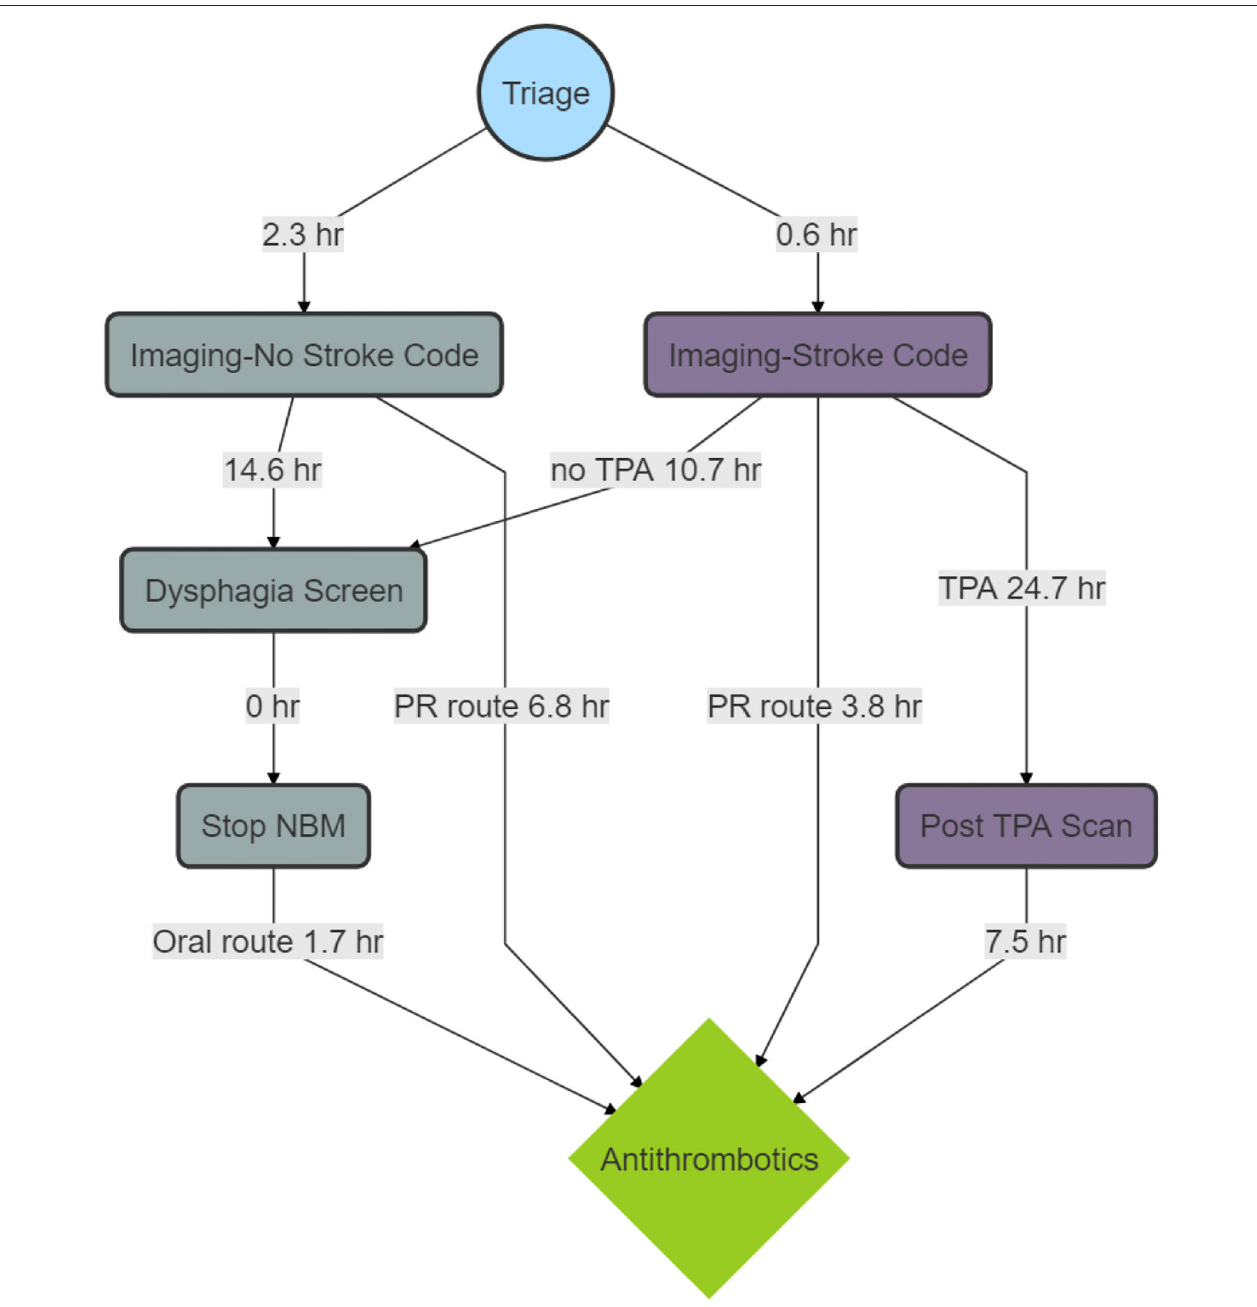
FIGURE 2 | Process map of median time to Antithrombotics. The figure shows a breakdown in timelines. There are delays between imaging and dysphagia screen and between dysphagia screen and stopping nil by mouth status (NBM). The delay between tissue plasminogen activator (TPA) and the post-TPA scan reflects the protocol to delay antithrombotic treatment for 24h. The delay between the post-TPA scan and antithrombotic administration reflects the delay in assessing the scan and issuing the order for